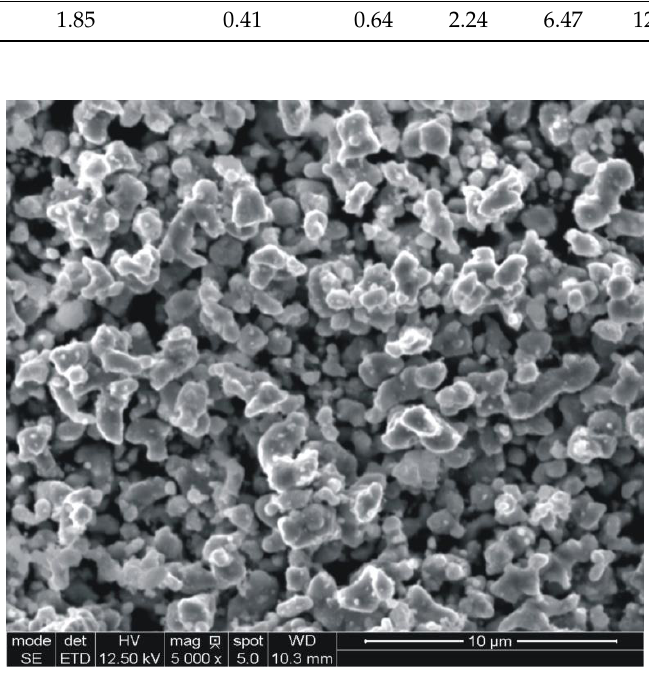
Figure 3. SEM micrograph of the experimental steel powder.